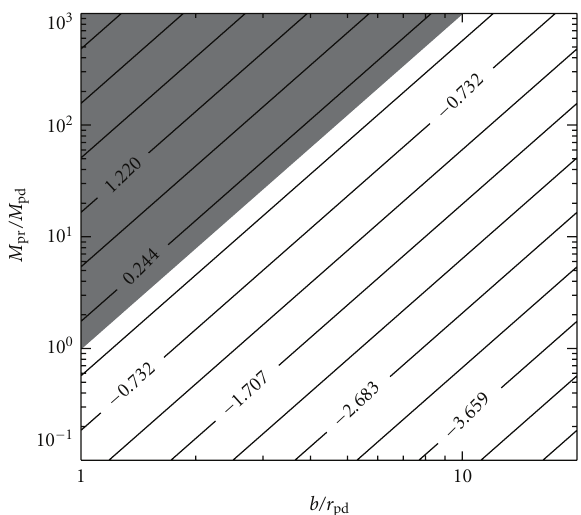
Figure 3: Contours of log( γ valid ) in the M pr /M pd - b/r pd parameter space, where γ valid is defined in Section 2. The shaded grey area indicates where the impulse approximation predicts nonzero mass